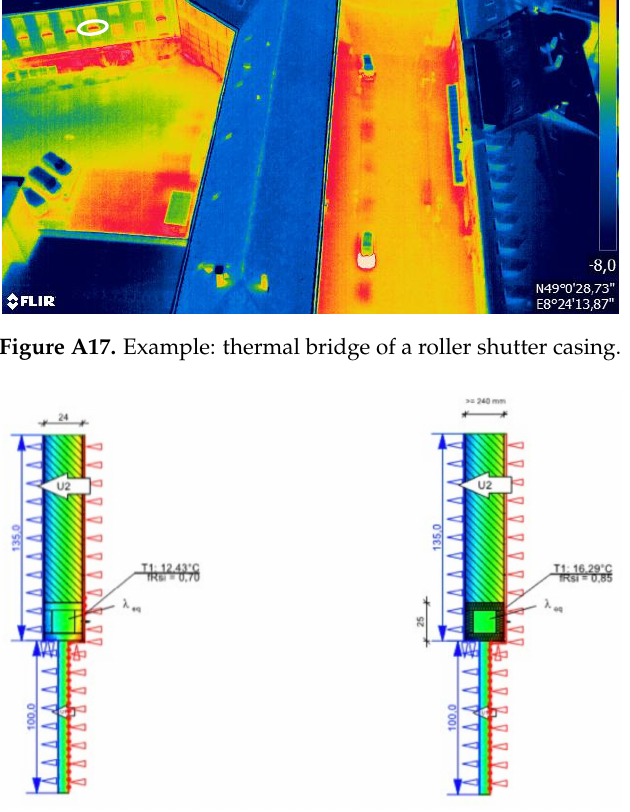
Figure A18. Before and after the thermal bridge retrofit of a roller shutter casing (created with ThermCad thermal bridge simulation